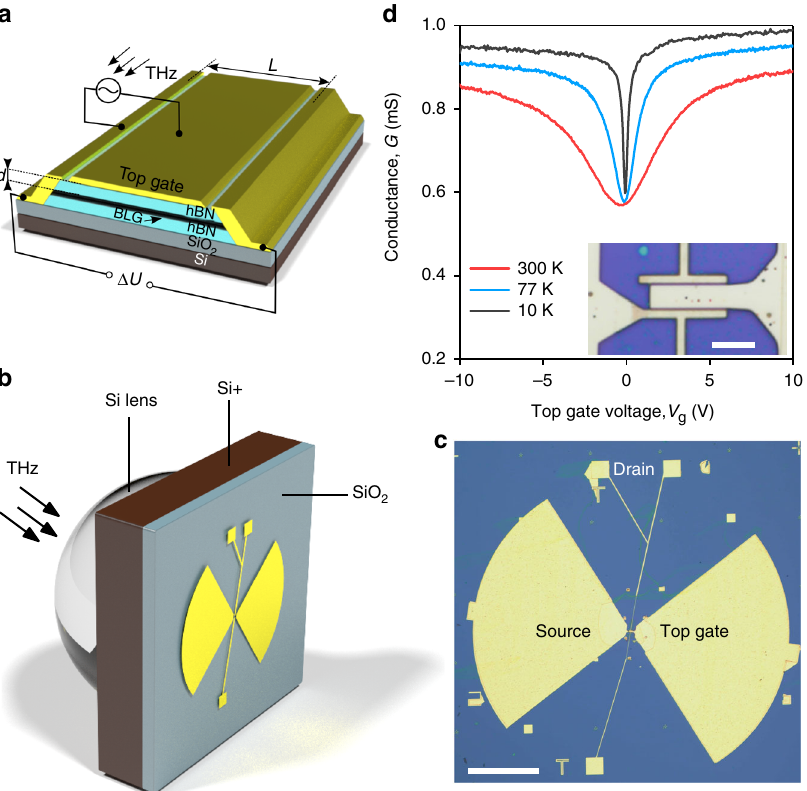
Fig. 1 Graphene-based THz detectors. a Schematics of the encapsulated BLG FET used in this work. b 3D rendering of our resonant photodetector. THz radiation is focused to a broadband bow-tie antenna by a hemispherical silicon lens yielding modulation of the gate-to-source voltage, as indicated in a . c Optical photograph of one of our photodetectors. Scale bar is 200 μ m. d Conductance of one of our BLG FETs as a function of the gate voltage V g , measured at a few selected temperatures. Inset: zoomed-in photograph of c showing a two-terminal FET with gate and source terminals connected to the antenna. Scale bar is 10 μ